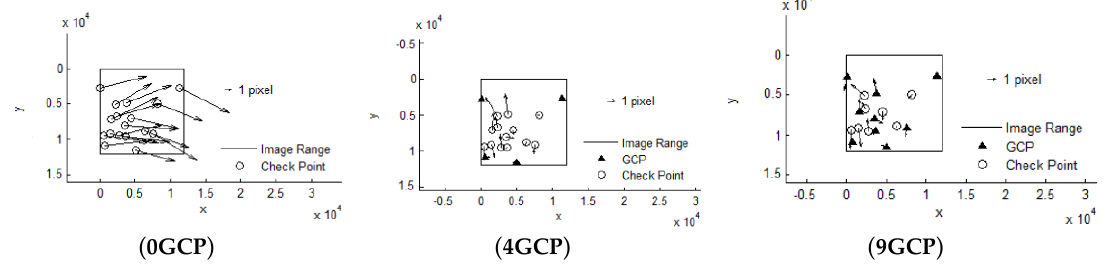
Figure 8. Residual distributions of check points of orientation for TH-1.